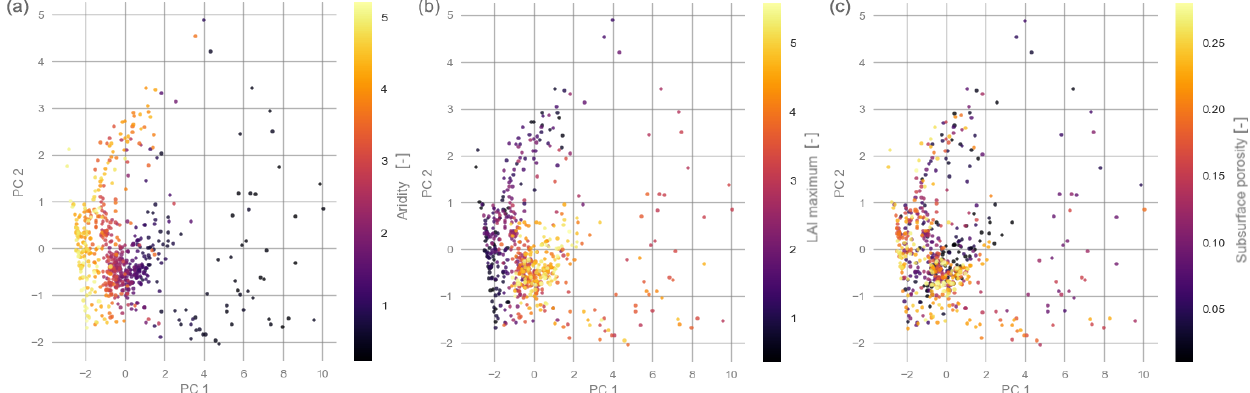
Figure A1. Patterns of catchment attributes in the PCA space of the hydrological signatures, with decreasing strength of the observed pattern from left (aridity) to right (subsurface